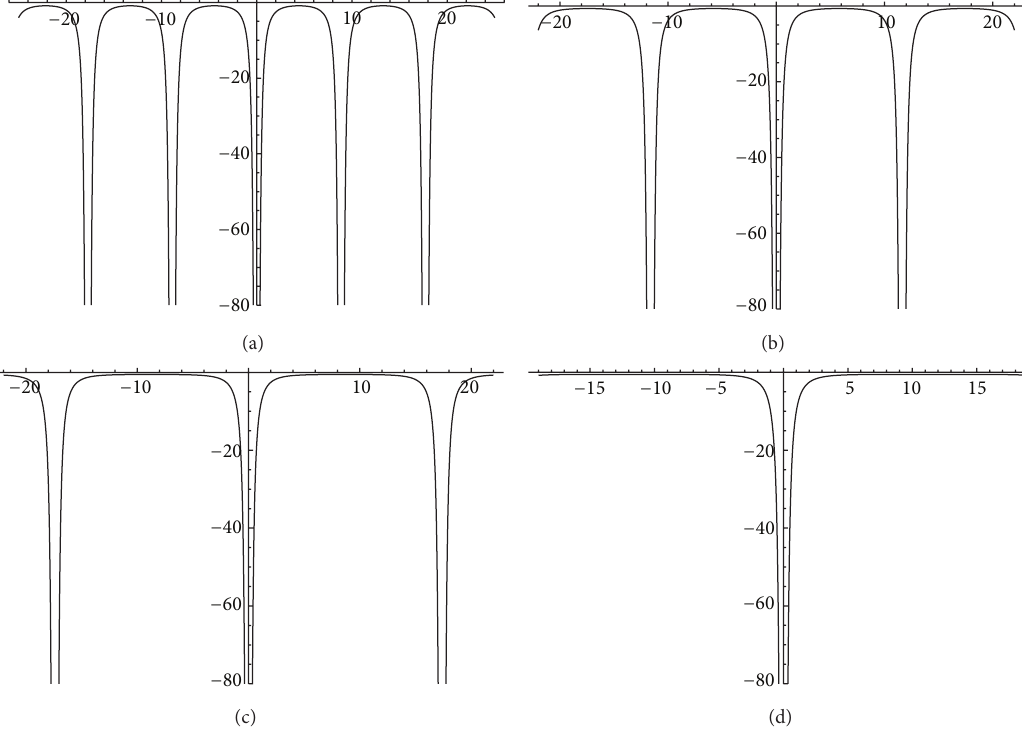
Figure 2: The varying process for graphs of 𝑢 7 (𝜉) when 𝑔 → 𝑔 2 − 0 , where 𝑎 = 1 , 𝑐 = 𝑏 = 𝑘 = 1/2 , and (a) 𝑔 = 𝑔 2 − 10 −1 ; (b) 𝑔 = 𝑔 2 − 10 −2 ; (c) 𝑔 = 𝑔 2 − 10 −4 ; (d) 𝑔 = 𝑔 2 − 10 −6 .